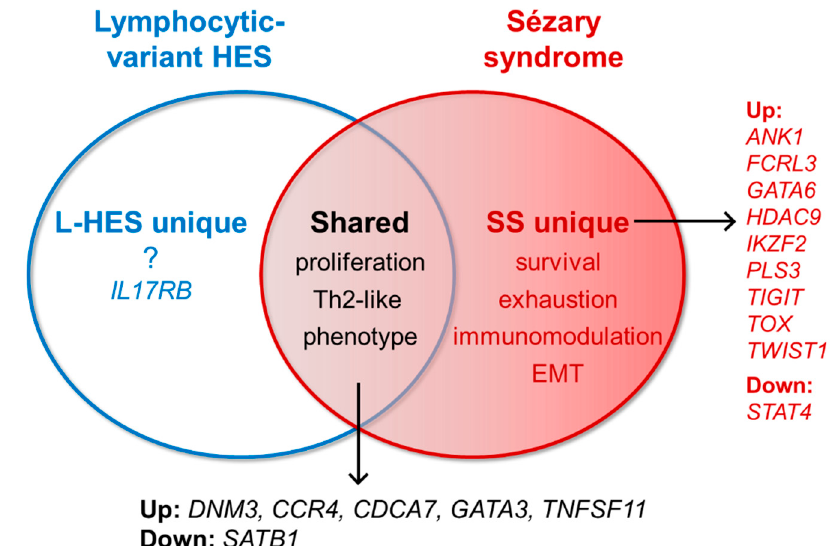
Figure 2. Overlap of di ff erentially expressed genes for L-HES and SS. Shared and unique gene expression in SS and L-HES are shown with relationships to their respective roles in disease, which may lead to diagnostic improvements. Red circle: Di ff erential gene expression in SS CD3 + CD4 + CD45RO + T cells compared to normal CD3 + CD4 + CD45RO + T cells [22]. Blue circle: Di ff erential gene expression in L-HES CD3 − CD4 + T cells compared to normal CD3 + CD4 + T cells [30]. Center overlap: Gene expression abnormalities shared by SS and L-HES may reflect benign or pre-neoplastic proliferative and inflammatory phenotypes. Excluded areas to the right and left represent abnormal gene expression unique to SS or L-HES, respectively. SS-unique genes have been associated with a number of cancer-promoting phenotypes.